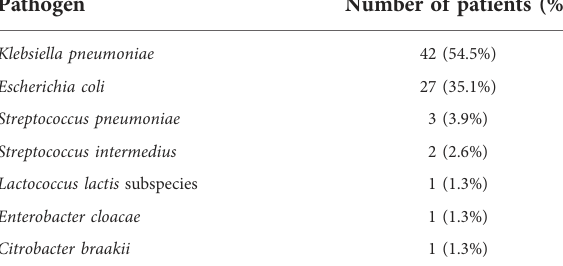
TABLE 3 Results of hemocultures or liver abscess fl uid cultures of patients with PLA.